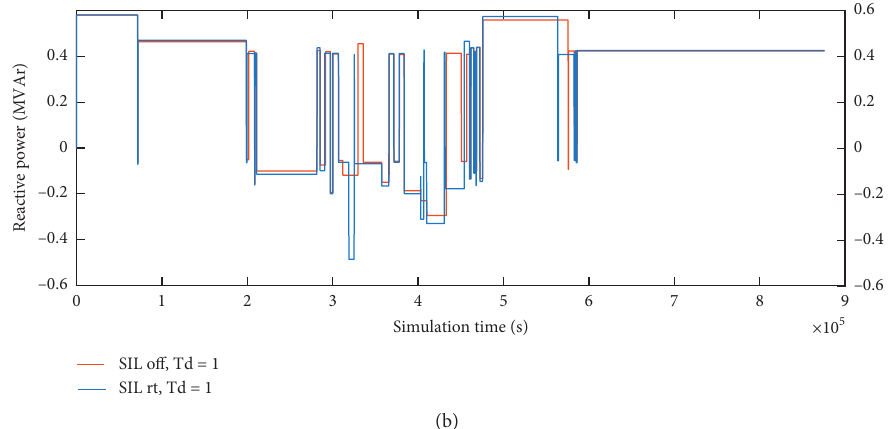
� 0.1 and 1. The d